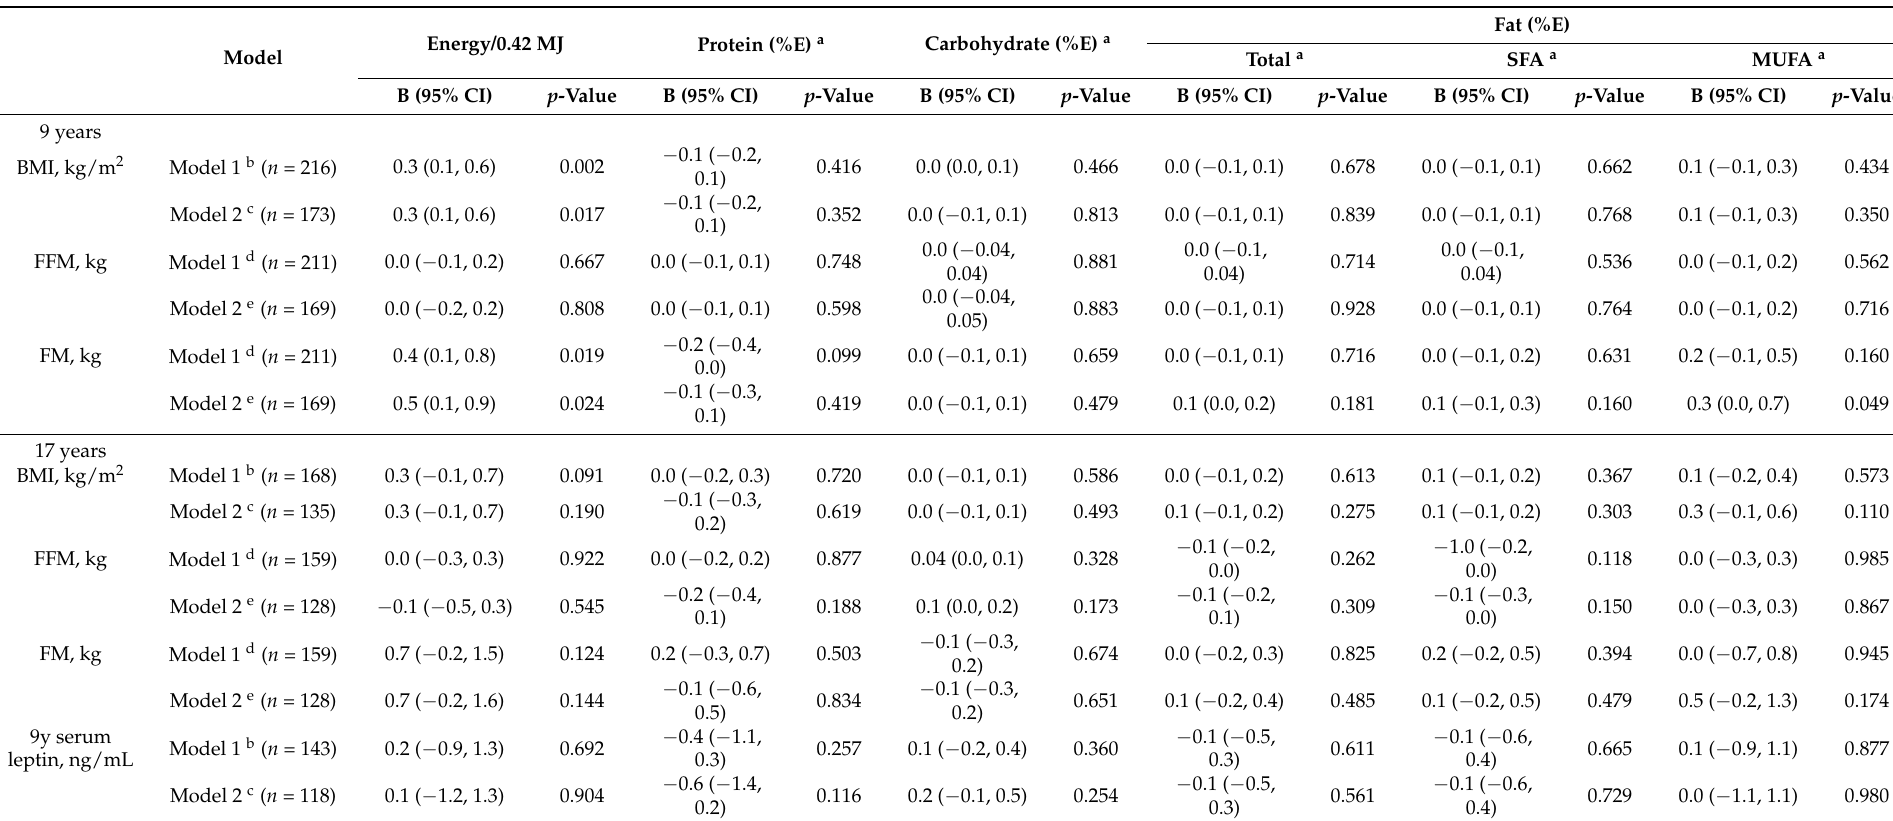
Table 5. Multiple linear regression models for energy and energy—adjusted macronutrient intakes of girls (plausible reporters only), using diet collected at 18 months of age to predict body composition, serum leptin concentration at 9 years of age and body composition at 17 years of age in children enrolled in